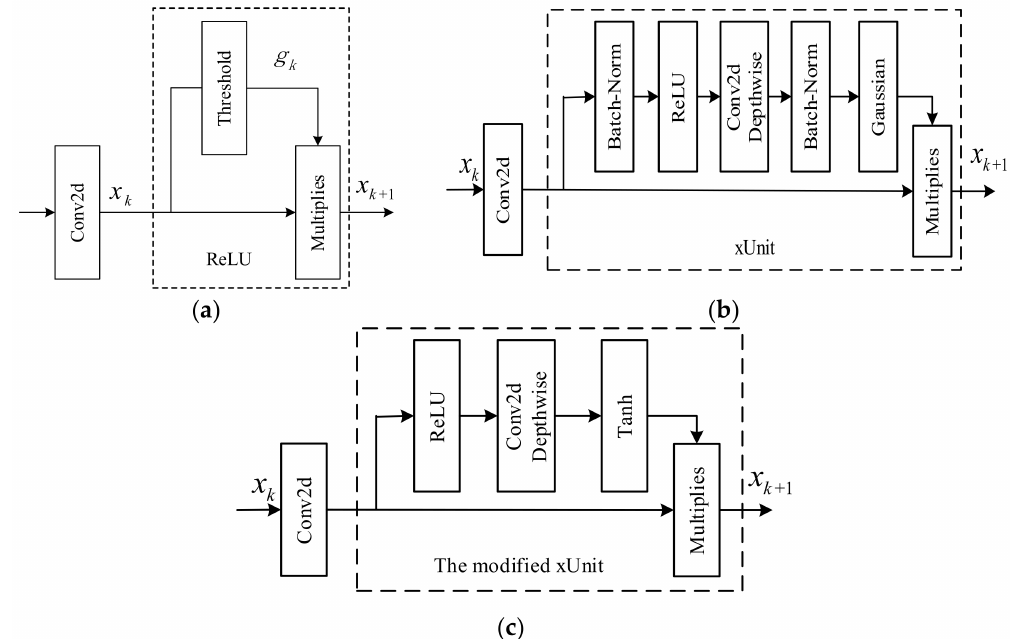
Figure 2. Three activation blocks: ( a ) the ReLU after derivation, ( b ) the structure of xUnit, ( c ) the modified